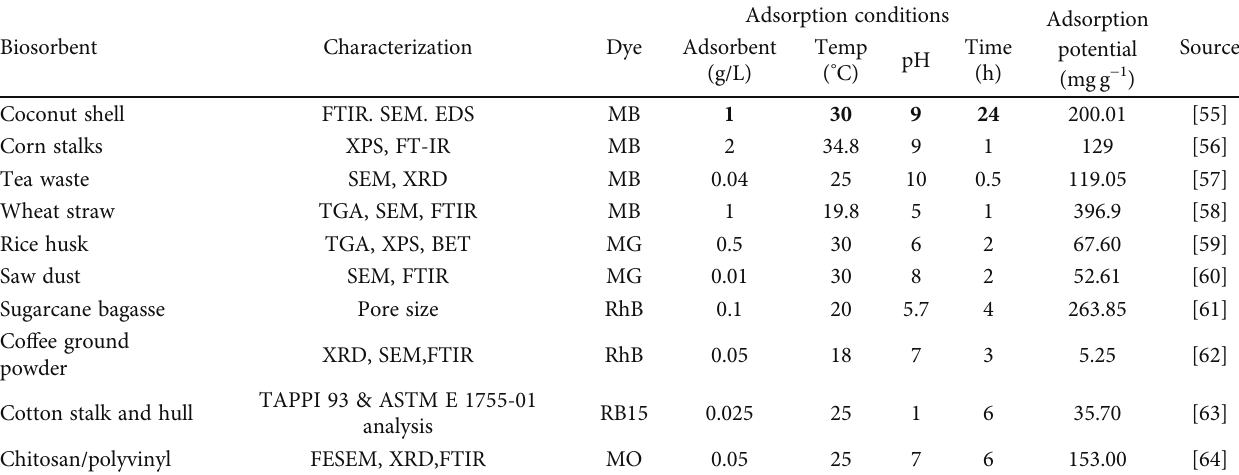
Table 2: List of common agro waste-based biosorbents used for removal of